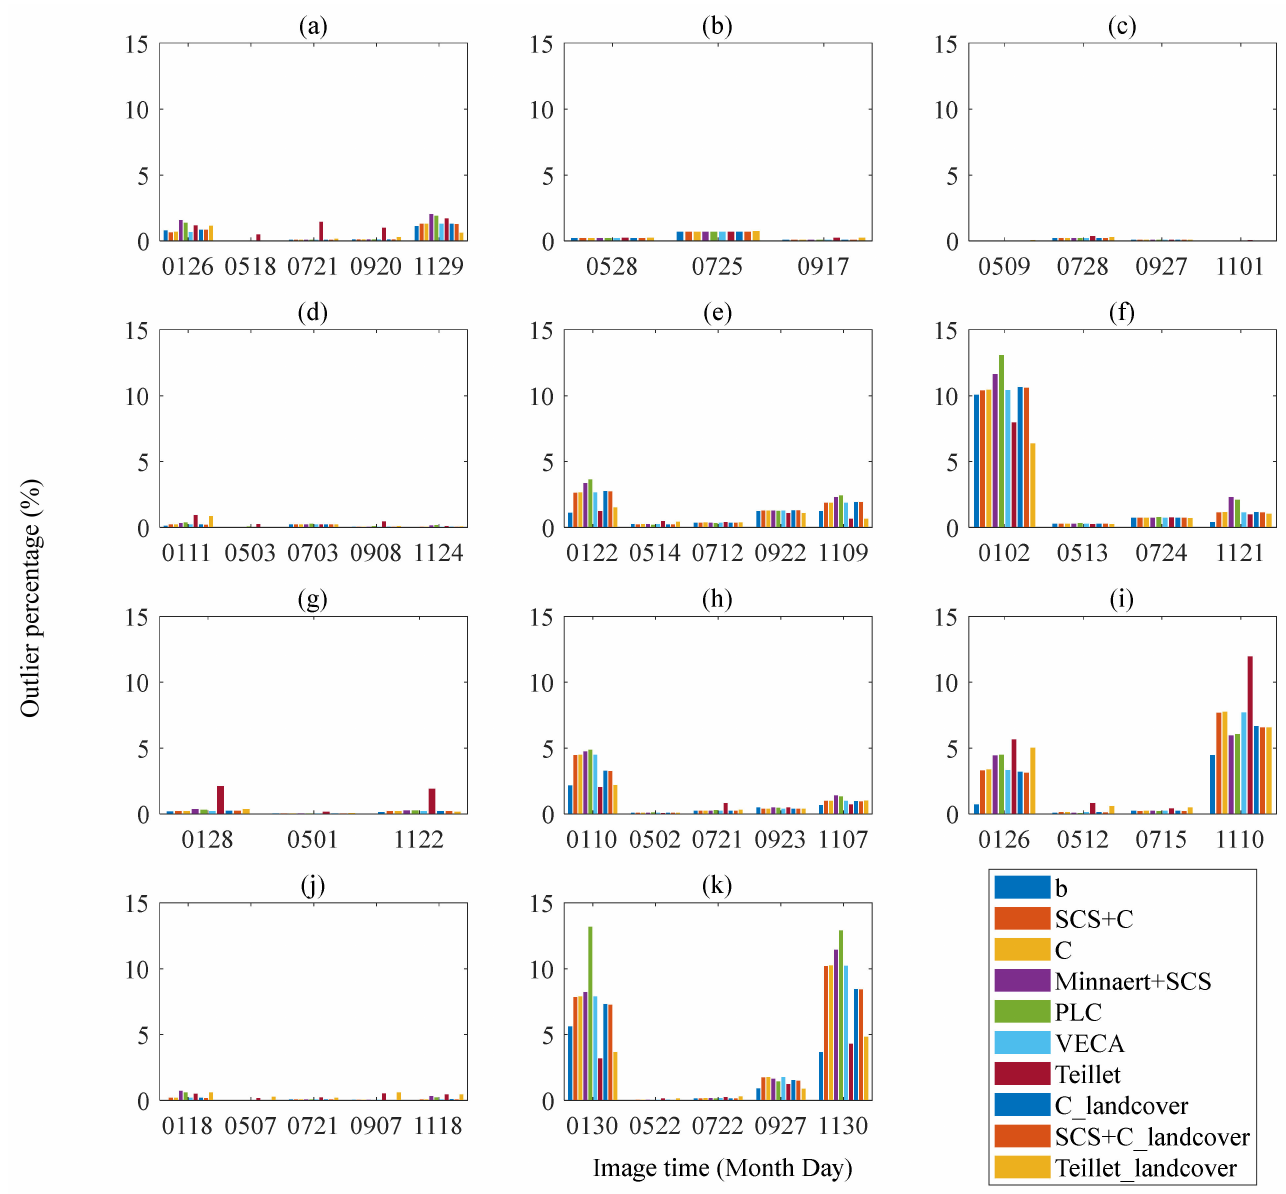
Figure 3. The outlier percentage in different Landsat footprint with different time. ( a ) path/row:120/039, ( b ) path/row: 121/024, ( c ) path/row: 121/042, ( d ) path/row:122/035, ( e ) path/row:124/032, ( f ) path/row: 128/036, ( g ) path/row:129/043, ( h ) path/row:131/035, ( i ) path/row: 131/038, ( j ) path/row: 139/040, ( k ) path/row: